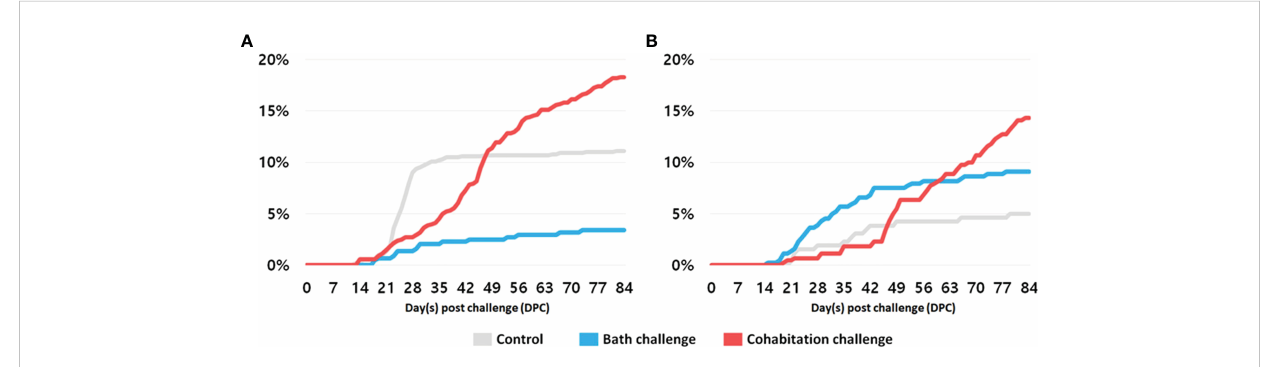
FIGURE 11 Cumulative mortality in fry (A) Atlantic salmon, and (B) brown trout in accordance with the different methods of PRV-1